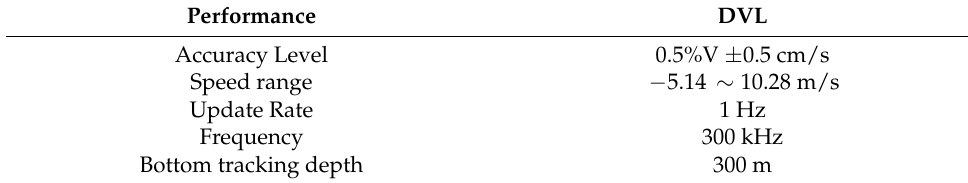
Table 2. The performance of